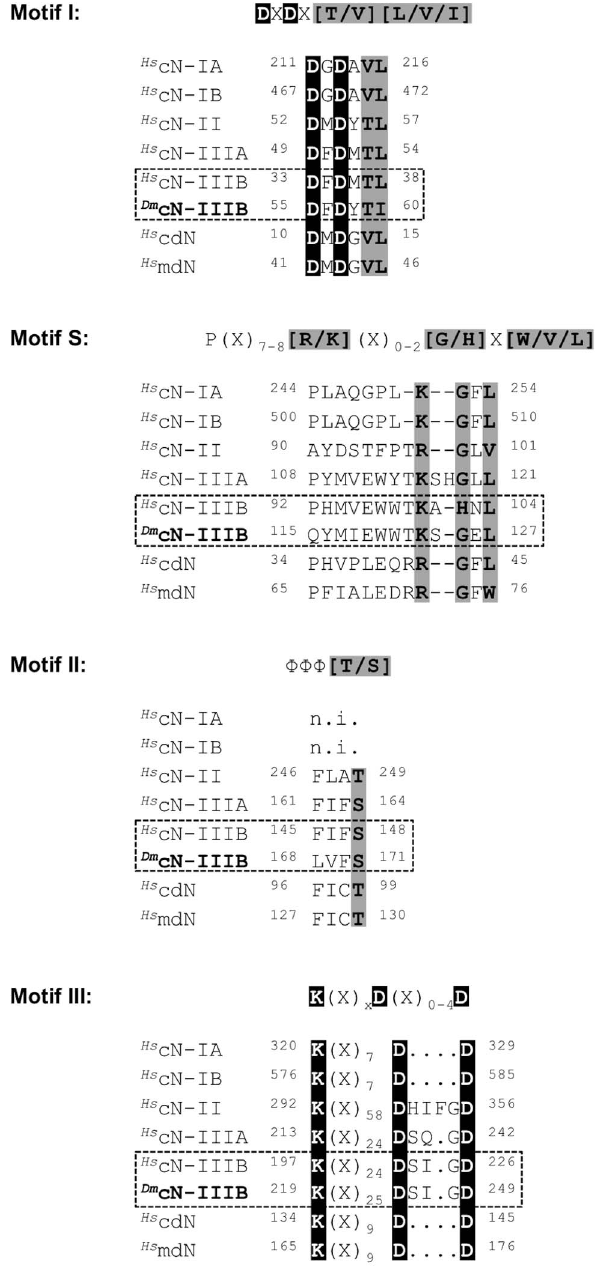
Figure 2. Conserved catalytic sequence motifs of the intracel- lular human 5 9 -nucleotidases and cN-IIIB. Sequence conservation of catalytic motifs of 5 9 -nucleotidases completed by the new member cN-IIIB. The respective motifs of Hs cN-IIIB and Dm cN-IIIB have been deduced from the crystal structure and sequence analyses. Shading indicates the different degrees of conservation from absolutely conserved (black) to partly conserved (grey). Motif I, II and III contain conserved catalytic residues and motif S contains residues involved in substrate recognition. Amino acids are numbered and consensus sequences are given above the